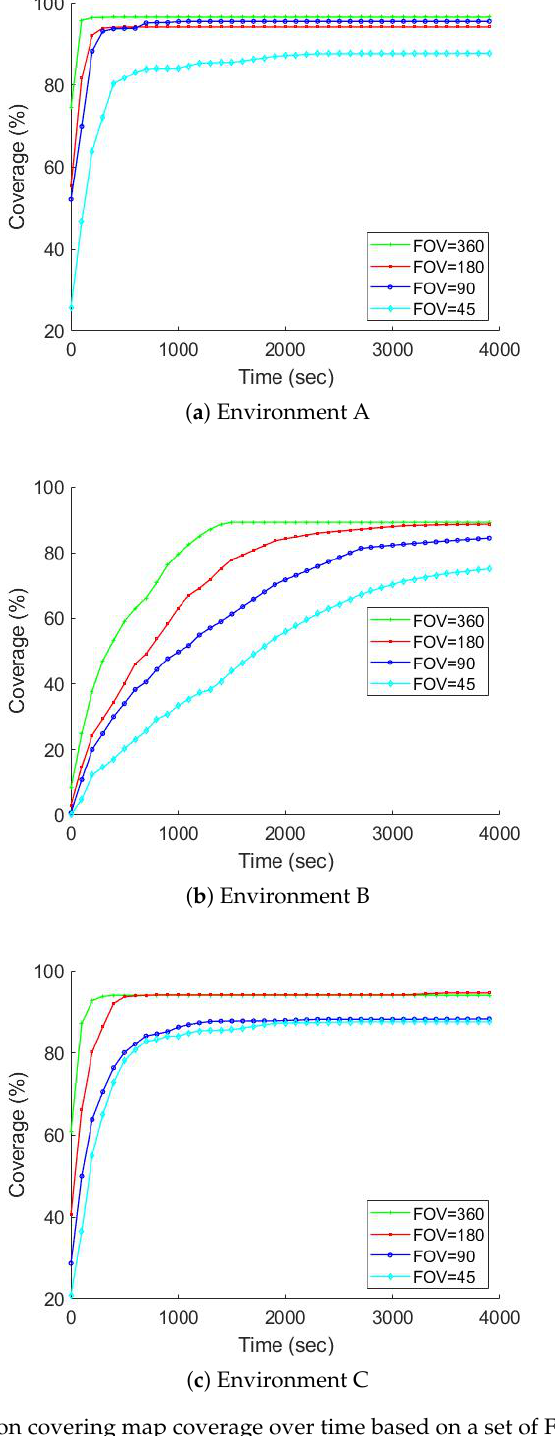
Figure 13. The radiation covering map coverage over time based on a set of FOV, AR is equal to 2.5 degrees, average over ten